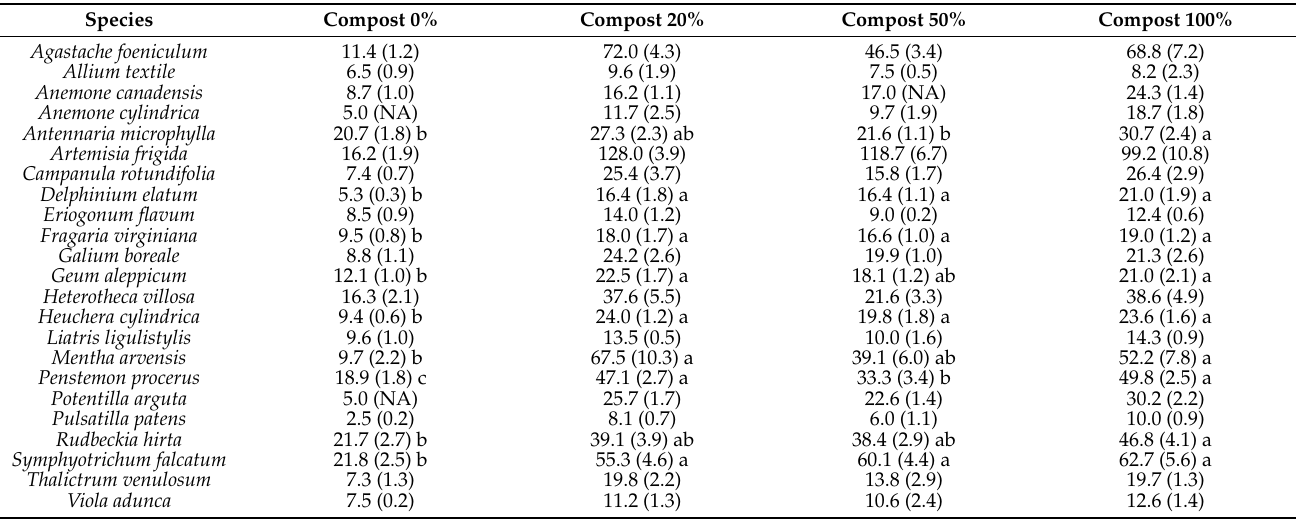
Table 2. Mean ( ± SE) spread (cm) by planted forb species in response to soil amendment treatments in year 2. Different letters within rows denote significant differences among treatments for species at α =